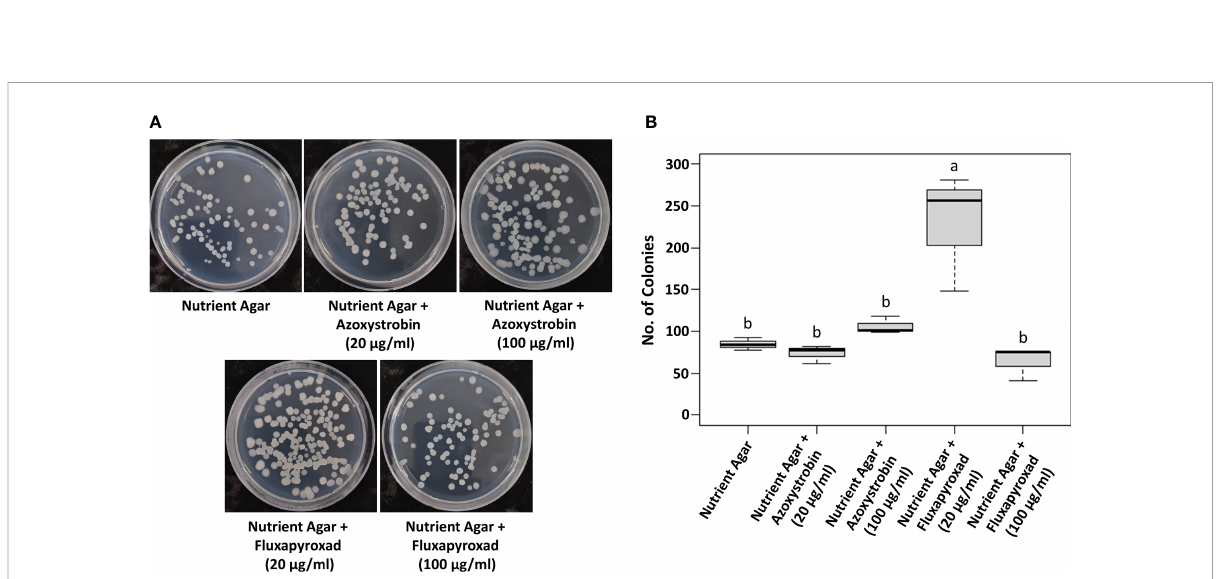
FIGURE 3 Compatibility of fungicides, azoxystrobin and fl uxapyroxad, with Bacillus velezensis GH1-13. (A) Bacterial colonies on NA medium (control) and NA medium amended with 20 m g ml -1 and 100 m g ml -1 of azoxystrobin and fl uxapyroxad. (B) Numbers of colonies were shown in the bar graph. Means followed by the same letter are not signi fi cantly different at P< 0.05 according to the Tukey ’ s HSD test.